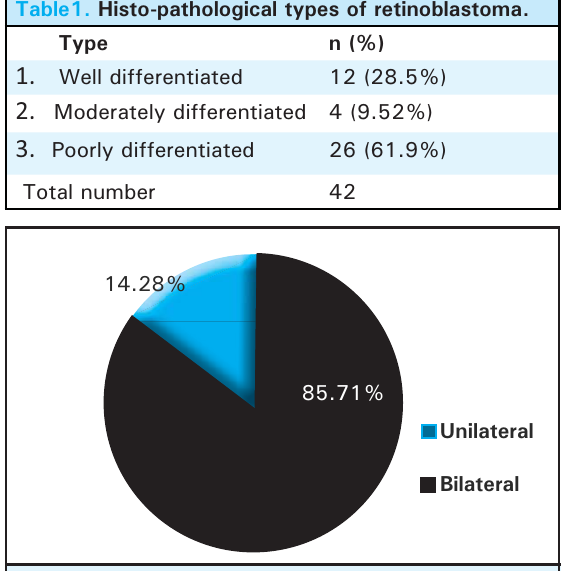
Figure 4. Showing optic nerve involvement in retino- blastoma